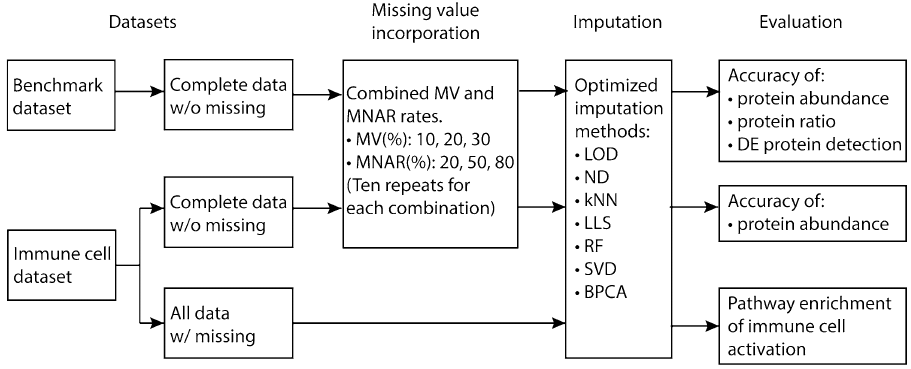
Figure 1. Analysis workflow. Missing values were incorporated into the benchmark dataset and complete part of the immune cell dataset in nine MV-MNAR combinations. Ten repeats were created for each MV-MNAR situation based on different random seeds. Datasets with missing values were imputed separately with seven methods: lowest of detection (LOD), random drawing from a left-censored normal distribution (ND), k-nearest neighbors (kNN), local least squares (LLS), random forest (RF), singular value decomposition (SVD) and Bayesian principal component analysis (BPCA). Accuracy of proteins abundances and intergroup protein ratios were compared based on normalized root mean square error (NRMSE) between real and after imputation. DE protein detection between Group B-D and Group A of the benchmark dataset was compared based on the amounts of true positives (TPs), false altered-protein discovery rate (FADR), and receiver operating characteristic (ROC) curves. The whole immune cell dataset with real missing values was imputed using seven methods, and enriched pathways of immune cell activation were